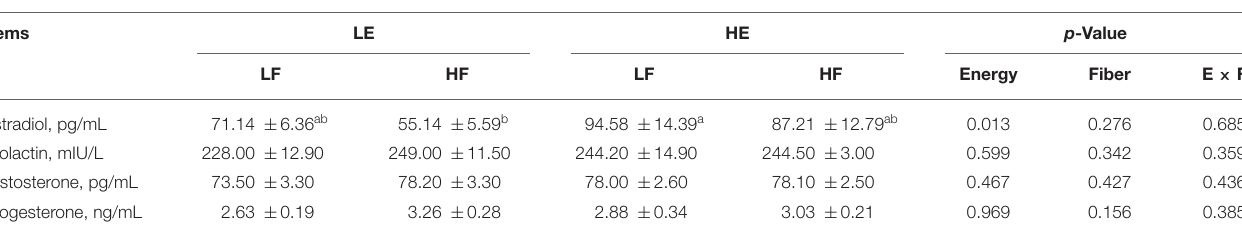
TABLE 2 | Effects of energy and fiber levels on serum hormone concentrations in gilts. Items LE